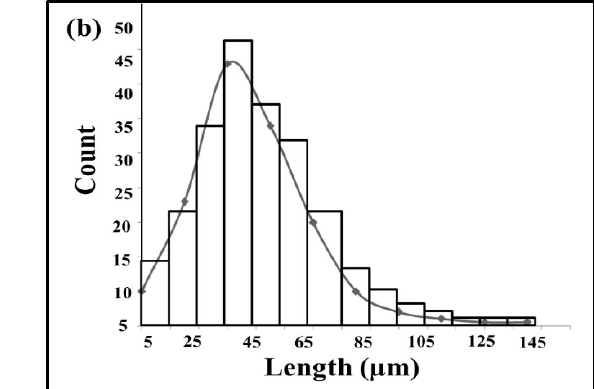
Figure 1. Schematic arrangement of the ( a ) friction stir processing and ( b ) aluminium alloy AL359 plate.